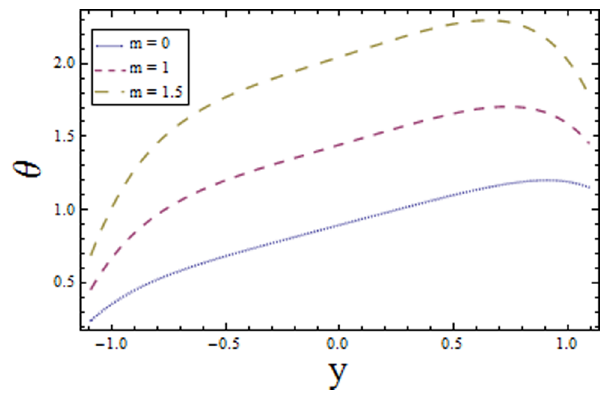
Figure 5. Plot of temperature h for Hall parameter m with E ~ 0 : 1 , t ~ 0 : 01 , x ~ 0 : 2 , ª 1 ~ 4 , ª 2 ~ 6 , E 1 ~ 0 : 4 ,